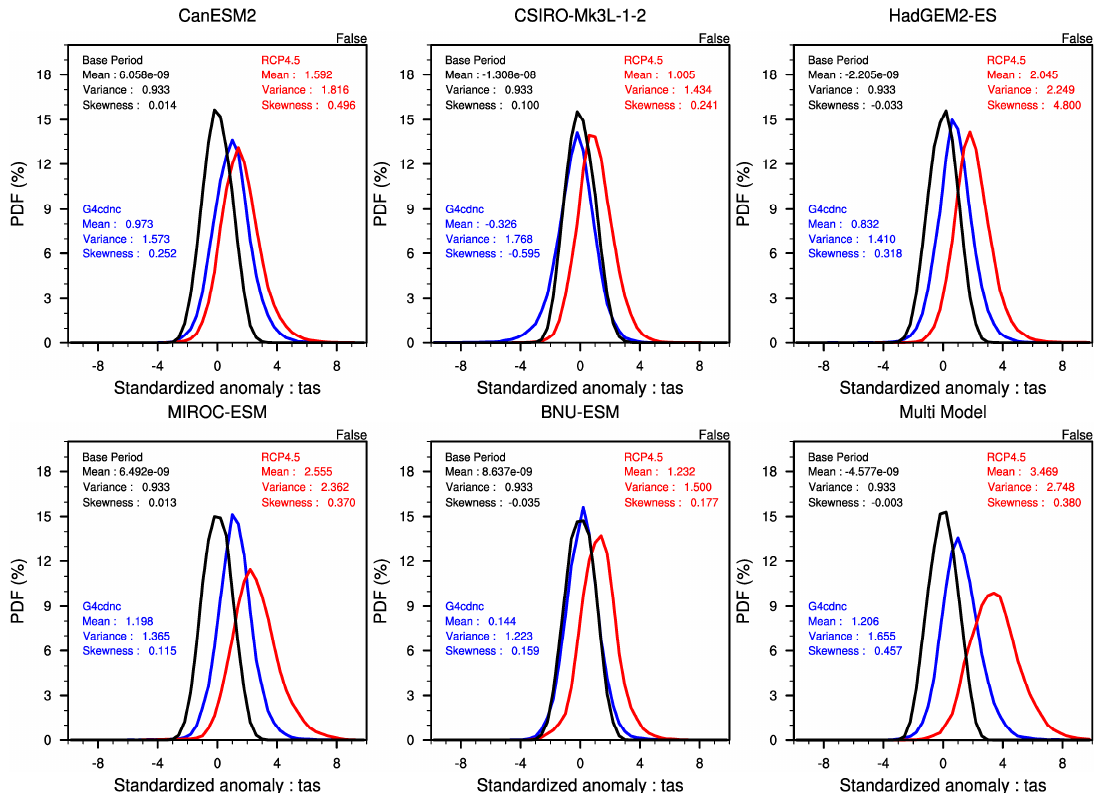
Figure 3. Probability distributions of standardized monthly mean anomalies for three experiments: G4cdnc (blue), RCP4.5 (red), and base period RCP4.5 (black). Probability density functions (PDFs) are over East Asia during the progress period (year 2060 to 2069). Anomalies are calculated with respect to the mean and standard deviation of the base period for the RCP4.5 scenario for each experiment. “False” shown in the upper right corner indicates that the difference in the distribution between G4cdnc and RCP4.5 is significant at the 95% level by the Kolmogorov–Smirnov test and “True” indicates vice versa.